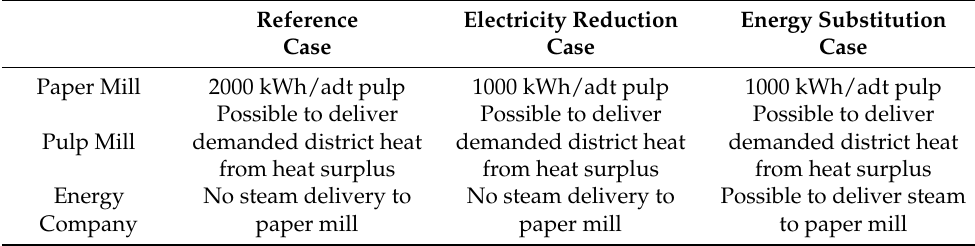
Table 1. Case differences in the research project. The paper mill defines the electricity reduction as a reference to the produced pulp, adt means air dry ton and is a standard unit in the